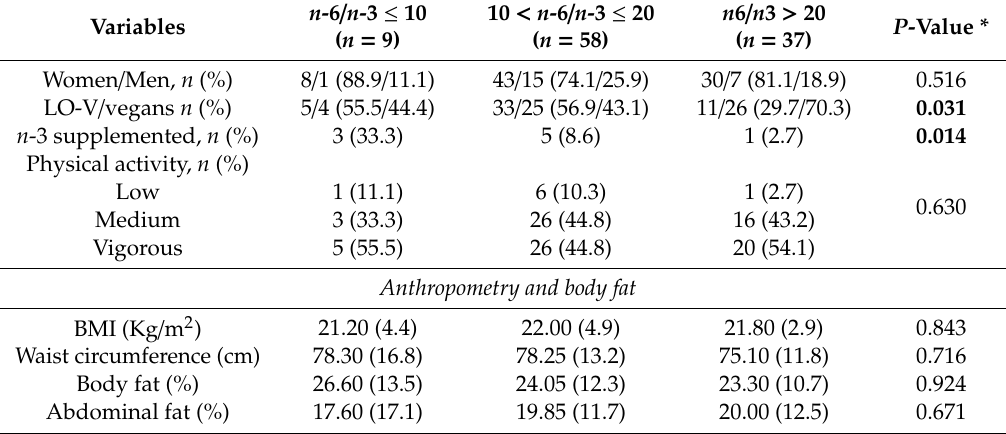
Table 4. Classification of volunteers according to n -6 / n -3